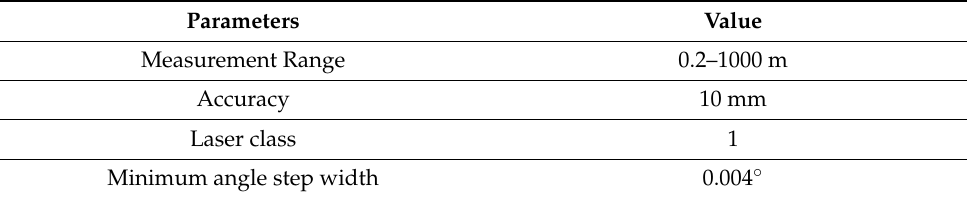
Table 1. Laser scanner hardware